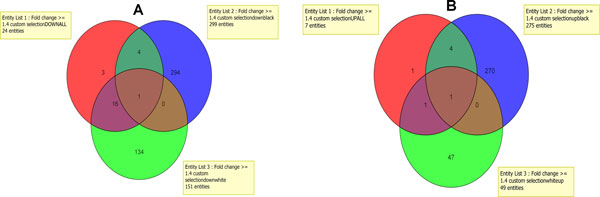
Venn diagrams for down-regulated and up-regulated genes in all mixed, AA and CAU T2D patients. a) Significantly down-regulated genes in mixed T2D patients are represented in red, AA in blue, and CAU in green. (b) Significantly up-regulated genes in mixed T2D patients are represented in red, AA in blue, and CAU in green.